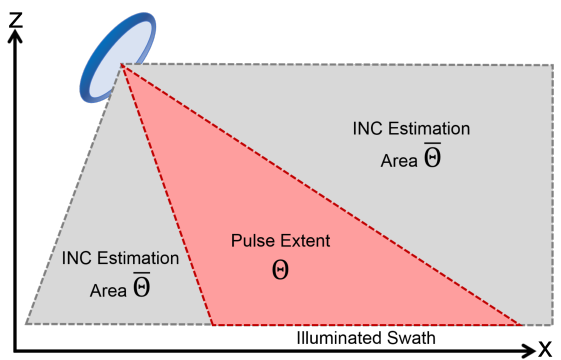
Figure 4. The estimation of the interference noise covariance (INC) matrix in the presence of the SAR signal is achieved by integrating the angular spectrum over the angular area ¯ Θ . The instantaneous SAR signal occupies the angular area Θ